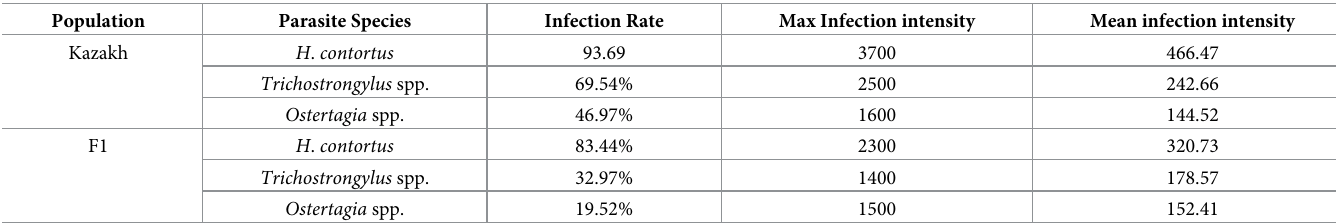
Table 9. Dominant species of sheep GINs in autumn.